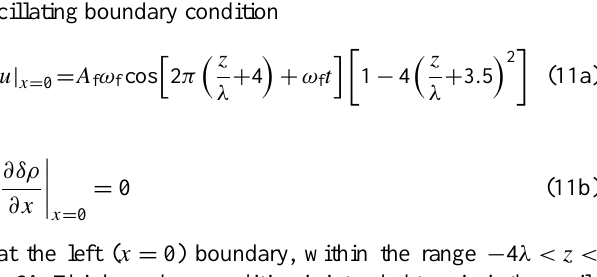
Figure 1 is a schematic of the simulations. An internal wave source with oscillation frequency ω f and thickness λ is lo- cated at the left edge of the simulation domain, in the range − 4 λ < z < − 3 λ . It generates a beam which travels upward through a uniformly stratified layer of fluid with buoyancy frequency N o until it passes through the pycnocline and re- flects from the base of the mixed layer. The simulations used two different frequencies to give incidence angles θ of 25 and 40 ◦ . The domain depth is 7.5 λ , while its length is 21 λ for the θ = 40 ◦ simulations and 25 λ for the θ = 25 ◦ simulations. points per element) are used, while the 25 ◦ simulations use 93 × 54 elements. The vertical resolution varies with depth; are eight elements within the pycnocline and two more on each pycnocline boundary. The horizontal resolution is uni- form except in the vicinity of the beam source, where the res- olution is more refined. Simulations were run for 20 internal wave beam forcing periods to reach a steady state.